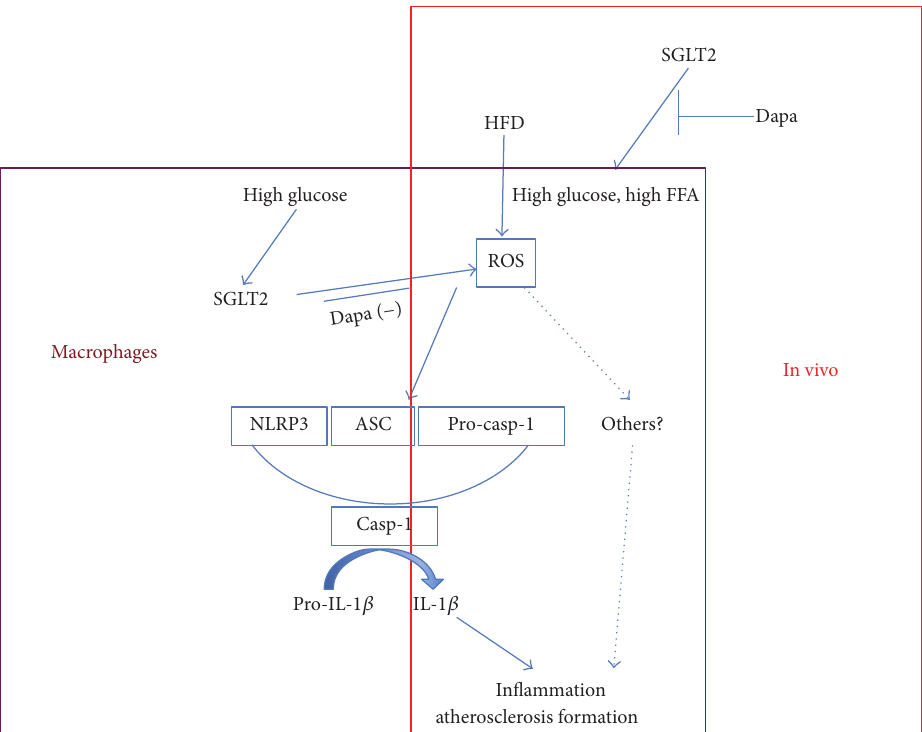
Figure 7: The possible signal pathway of high glucose and high FFA activation NLRP3 inflammasome through ROS production and the possible interfering site of